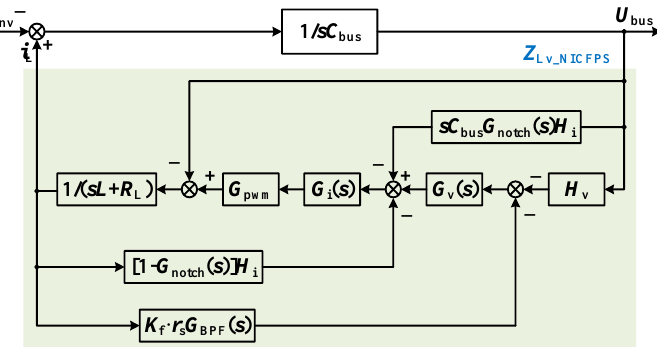
Figure 7. Block diagram for Z Lv_NICFPS (s) of the proposed scheme.